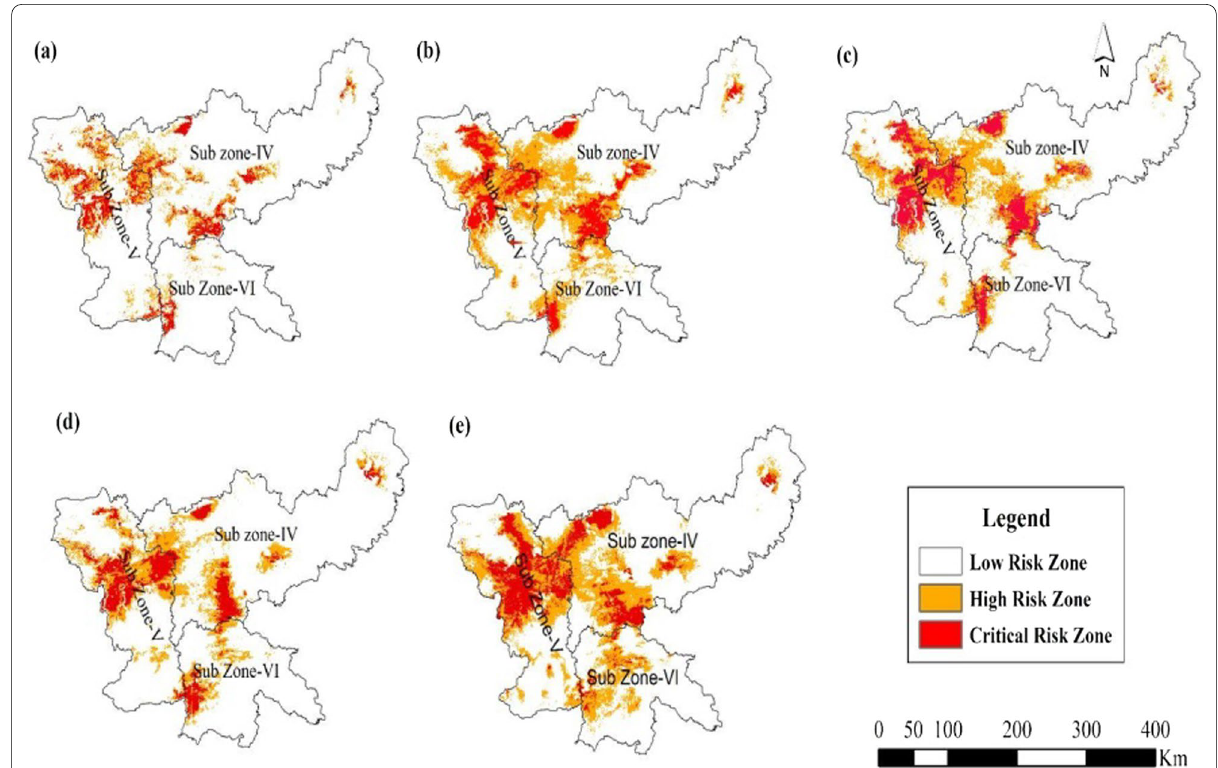
Fig. 5 Map showing potential distribution range of suitable habitats of L. camara for ( a ) 2020 and 2050 under RCPs ( b ) 2.6, ( c ) 4.5, ( d ) 6.0, and ( e ) 8.5 in Jharkhand. Map demonstrates further expansion in potential distribution range of L. camara by 2050 in Jharkhand encompassing the agro-climatic sub-zones IV, V and VI across all the RCPs i.e. 2.6, 4.5, 6.0 and 8.5 with maximum possible expansion under the scenario RCP 8.5. The probability of distribution is higher in high and critical risk zones than low risk zones